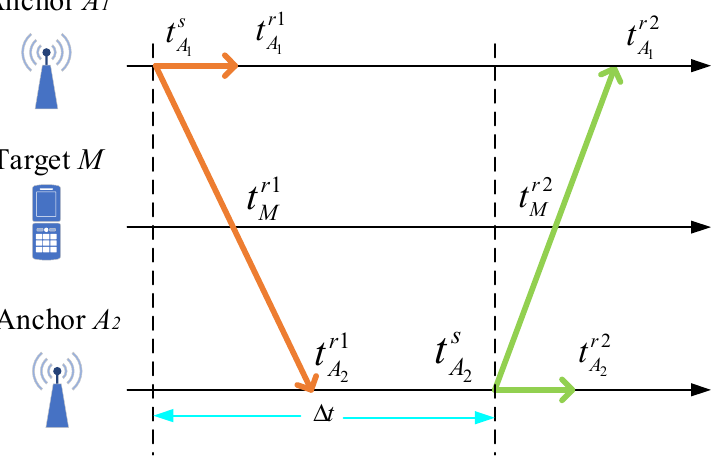
Figure 4. Diagram of message transmission and reception between two anchors and one target.